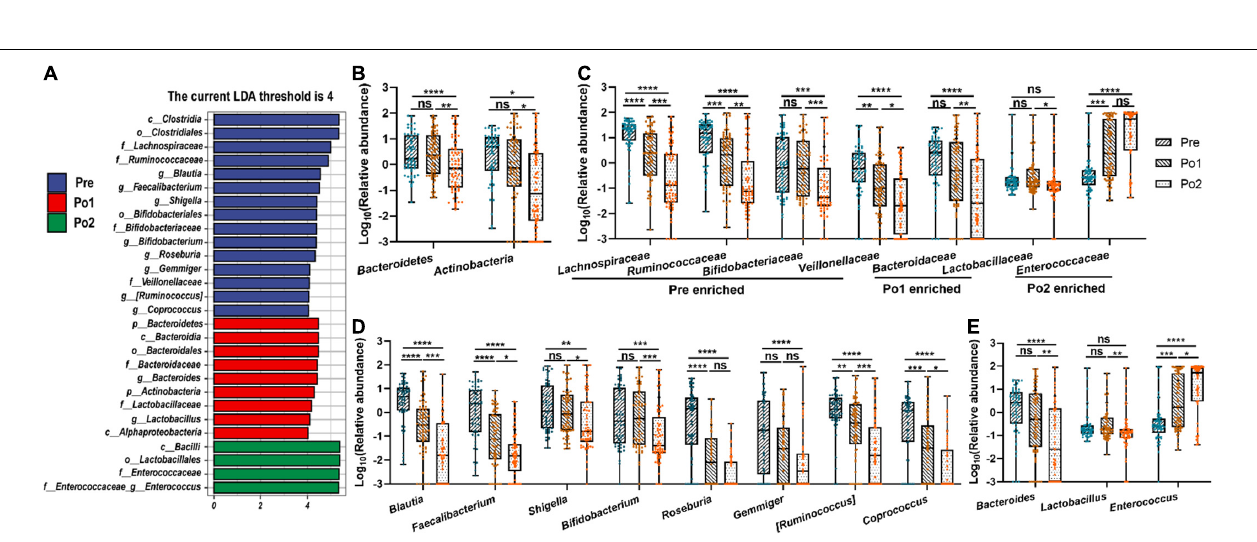
Frontiers in Microbiology |